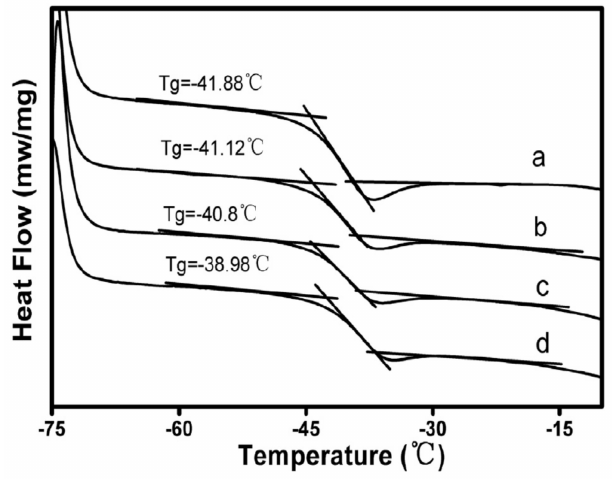
Figure 35. Glass transition temperature of ( a ) ENR; ( b ) SENR/GO-0.3; ( c ) SENR/GO-0.5, and; ( d ) SENR/GO-0.7 [97].